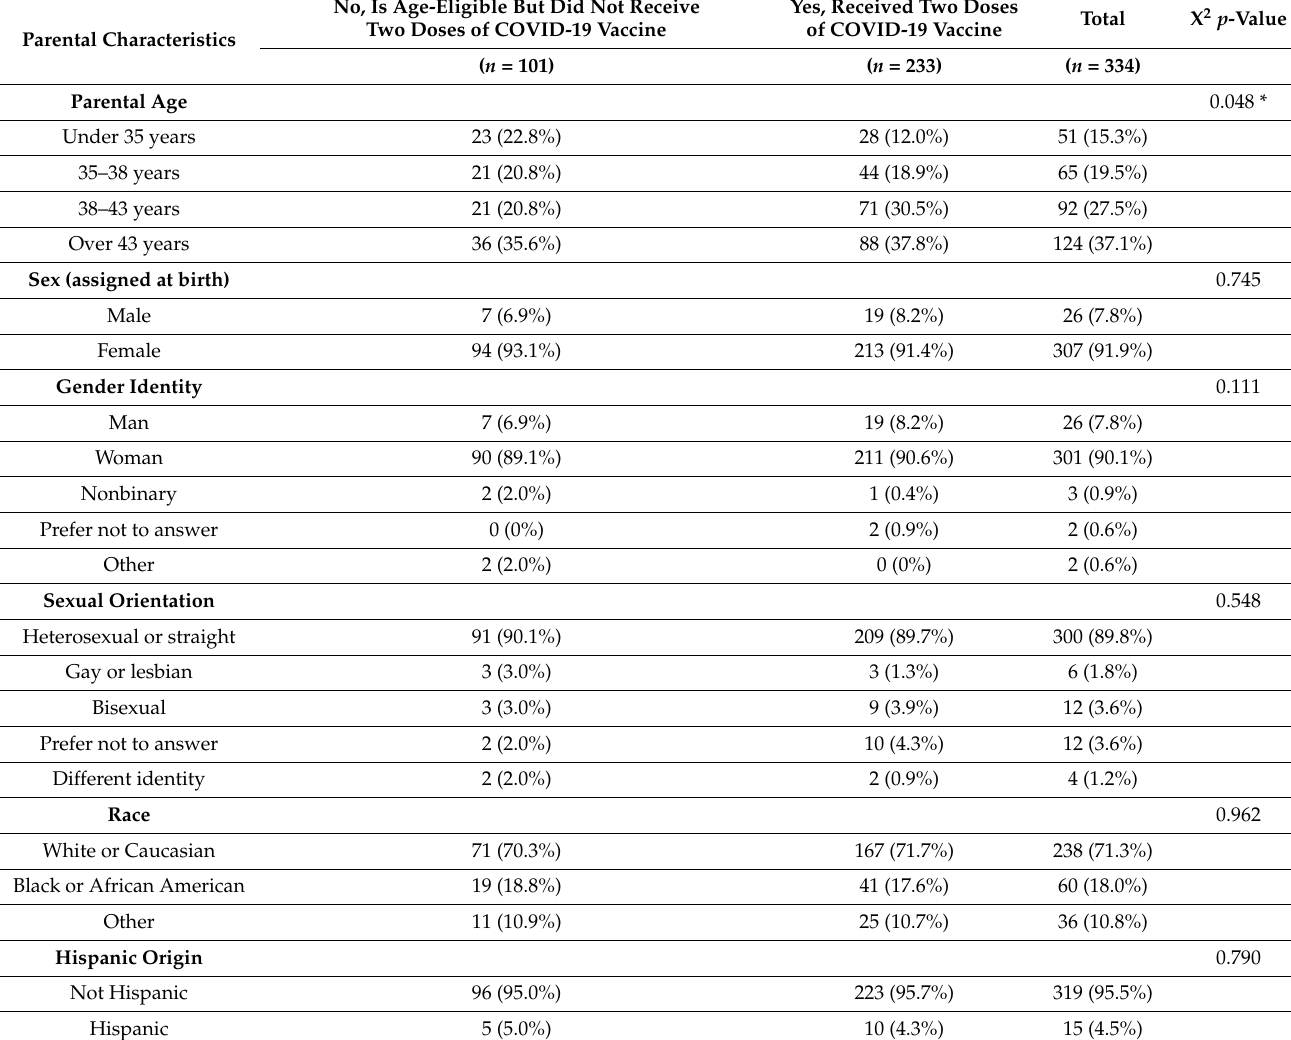
Table 1. Sociodemographic characteristics of survey respondents with age-eligible children, stratified by receipt status of two doses of COVID-19 vaccine for their eldest child ( n =